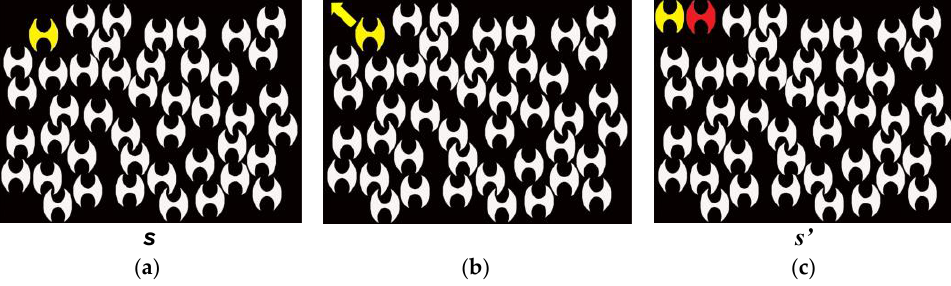
Figure 2. Neighborhood structure from the movements of the figures. ( a ) Piece F (yellow color), chosen in a solution s . F movement, modifying its coordinates. New piece G (red color) inserted in s chosen in a solution s . ( b ) F movement, modifying its coordinates. ( c ) New piece G (red color) generates s' . inserted in s generates s (cid:48)